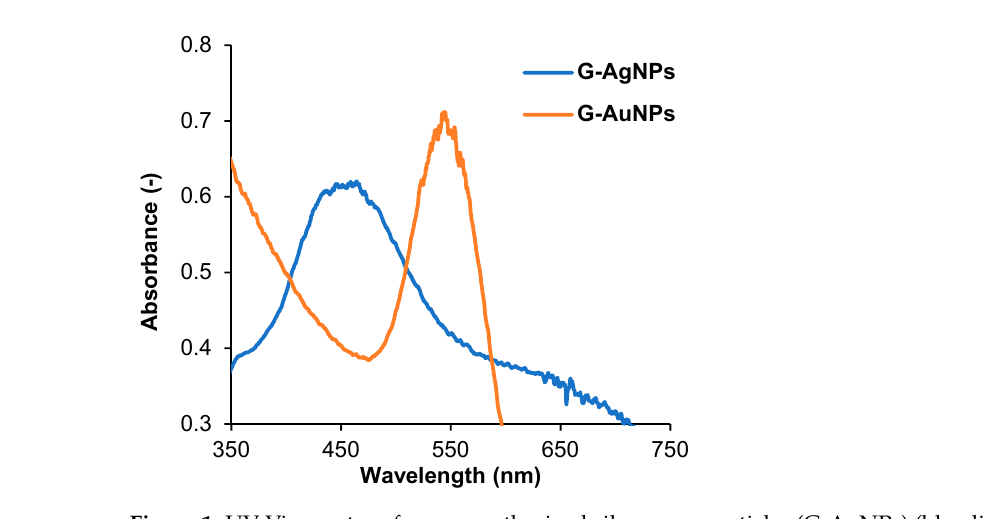
Figure 1. UV-Vis spectra of green synthesized silver nanoparticles (G-AgNPs) (blue line) and gold nanoparticles (G-AuNPs) (orange line).